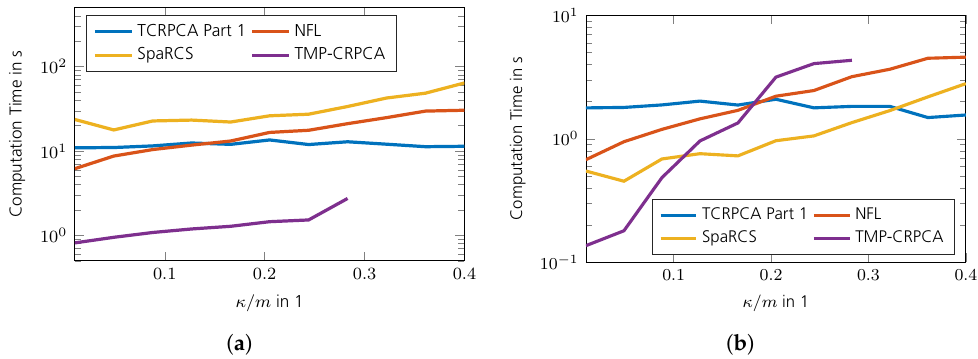
Figure 19. Comparison of computation time for ρ = 3 and m / n = 0.8, i.e., in an interval where all algorithms perform equally well. For NFL, SpaRCS, and TMP-CRPCA, the results are shown for K = κ and R = ρ only. For κ / m > 0.3, TMP-CRPCA did not converge and is thus not shown here. ( a ) Noislet sensing operators. ( b ) DFT sensing operators with random